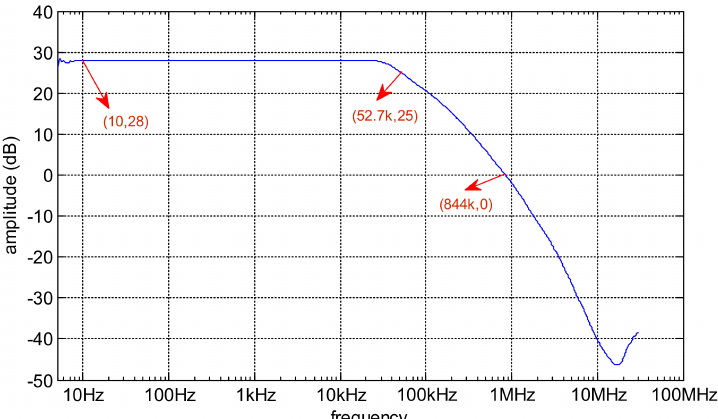
Figure 24. Measured frequency–amplitude characteristic for the power amplifier using general operational amplifiers.